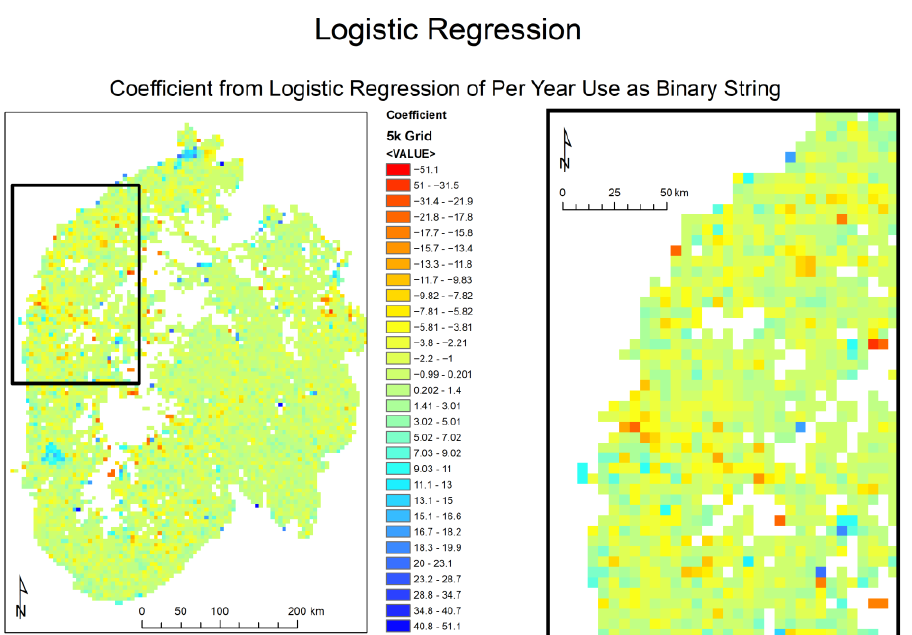
Figure 6. Logistic regression is used to analyze the probability for a prediction of 1 (in use) given a binary string of 1 or 0 for each year from 2003 to 2014. The coefficient visualizes the trend in this probability over time. The map on the left shows southern parts of Norway, while the figure on the right shows the map in the frame with higher resolution.